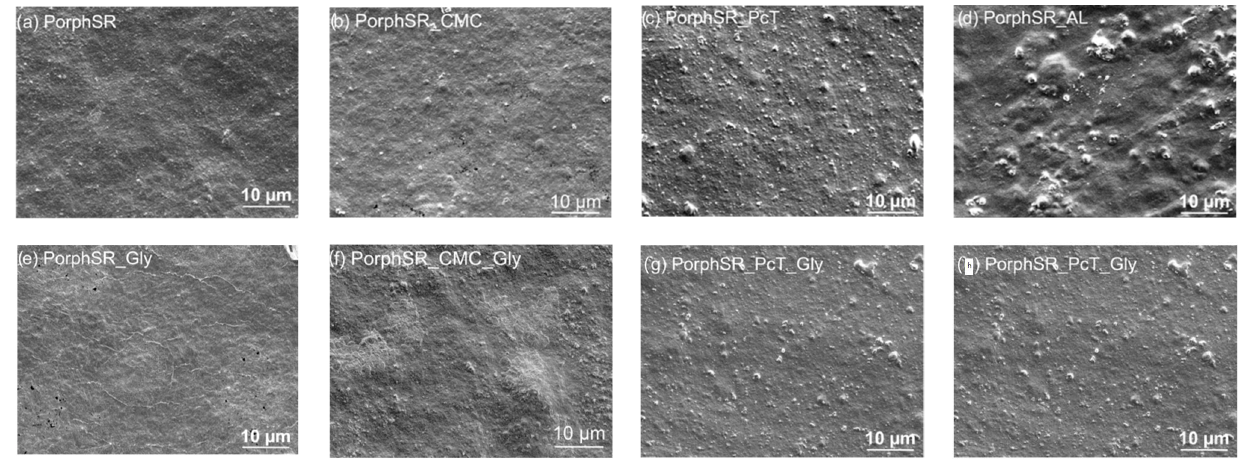
Figure 3. SEM images of the produced films. Without added glycerol: ( a ) PorphSR; ( b ) PorphSR_CMC; ( c ) PorphSR_PcT; ( d ) PorphSR_AL. With added glycerol: ( e ) PorphSR_Gly; ( f ) PorphSR_CMC_Gly; ( g ) PorphSR_PcT_Gly; ( h ) PorphSR_AL_Gly.